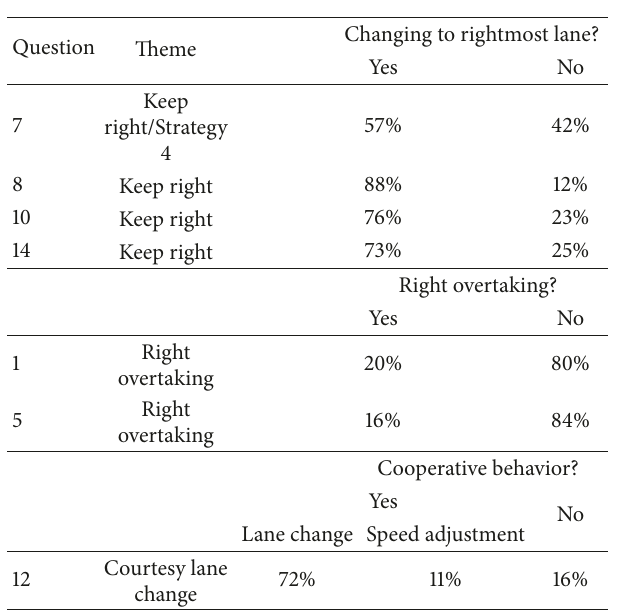
Table 4: Distribution of respondents to behavior characteristics.